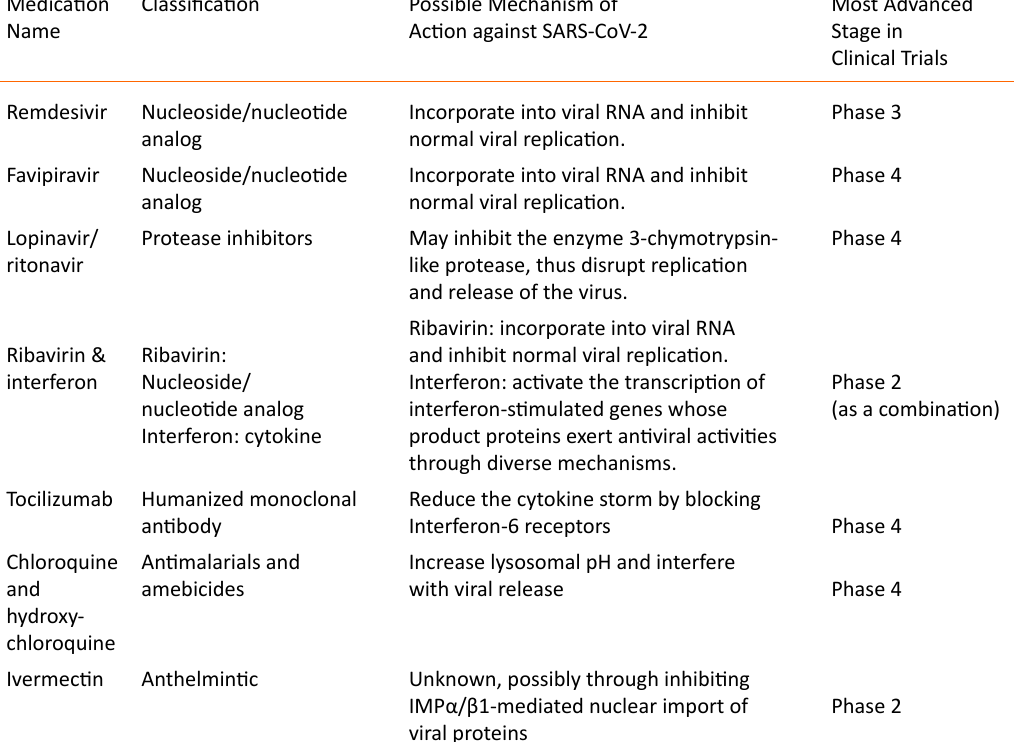
Table 1. Potential COVID-19 drugs under